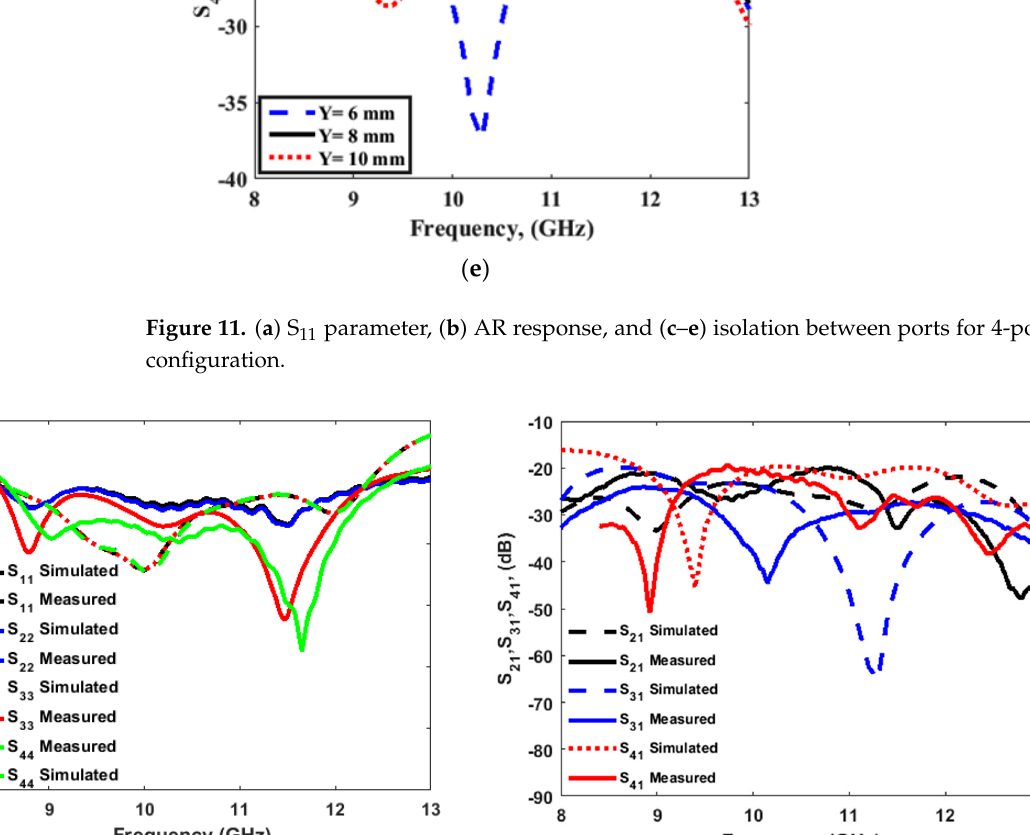
Figure 13. AR response of four-port CP MIMO DRA (simulated and measured).